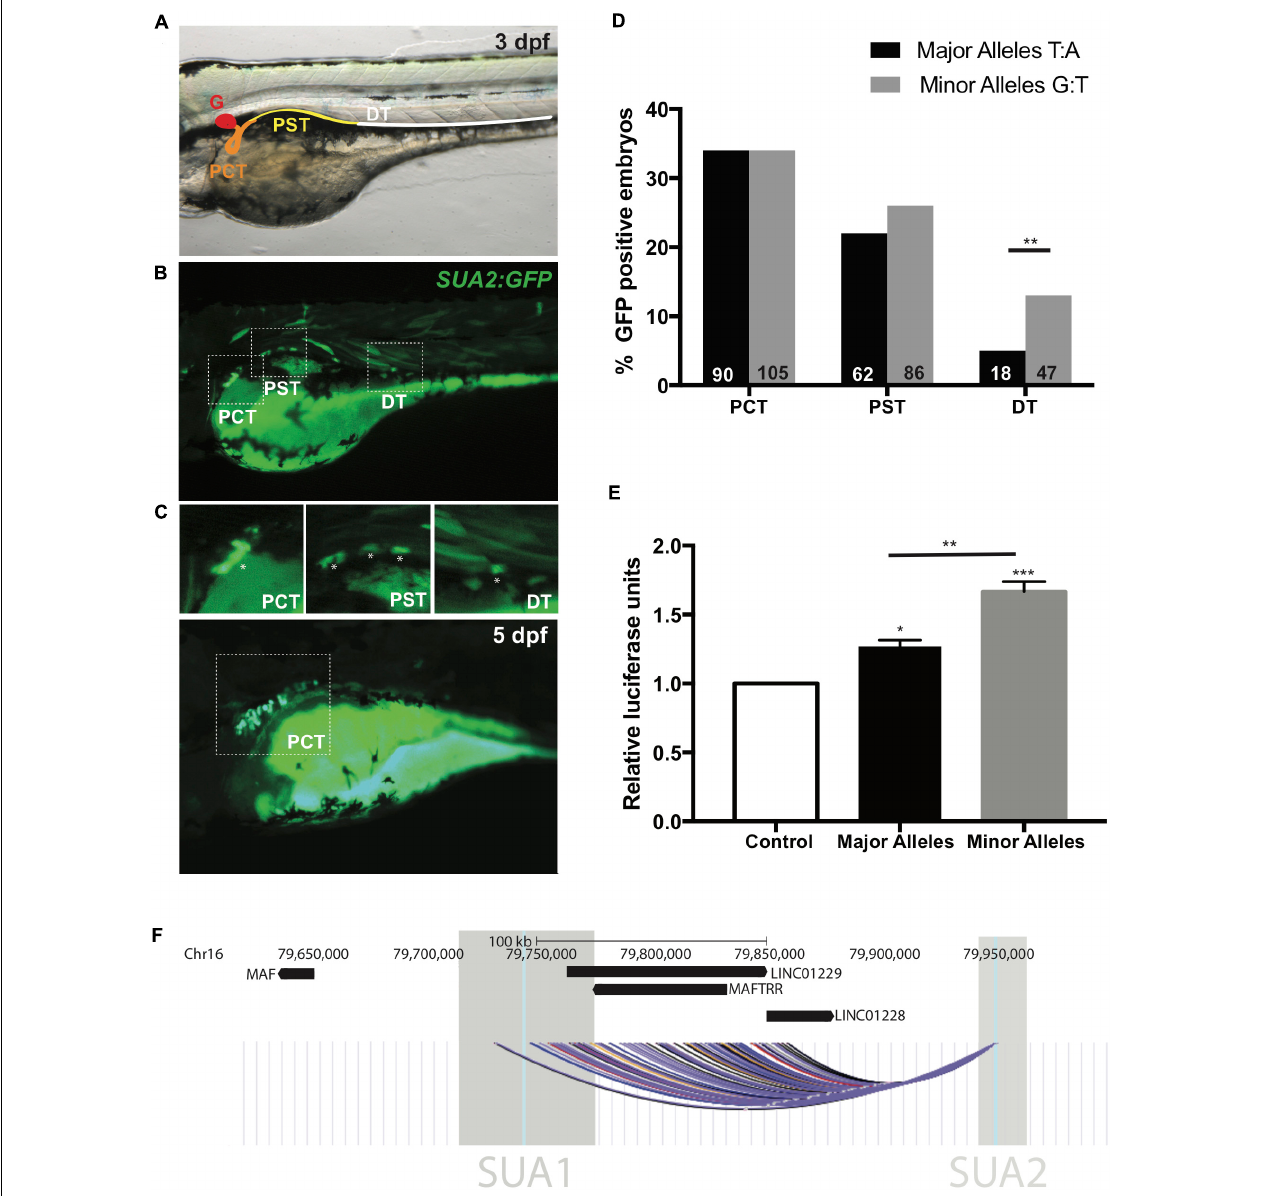
FIGURE 3 | SUA2 is a functional enhancer that physically connects to the lincRNA region. An enhancer construct containing the SNP region (e.g., major alleles) injected at the one-cell stage in developing zebrafish embryos drives transient GFP reporter expression in the proximal tubules of 24 hpf, 48 hpf, and 3 dpf embryos. (A) 48 hpf embryo with schematic depicting the zebrafish pronephros: glomerulus (G, red); proximal convoluted tubule (PCT, orange); proximal straight tubule (PST, yellow); distal tubule (DT, green). (B) Representative image from a 3 dpf embryo with mosaic GFP expression in the PCT, PST and DT. Insets of the PCT, PST and DT are below. Asterisks indicate GFP positive cells. (C) Representative image from a 5 dpf embryo with mosaic GFP expression found exclusively in the PCT. (D) Percentage of transgene positive embryos that present with GFP-positive cells in the PCT, PST, and DT in enhancer constructs containing the SNP region with either the major or minor alleles for SNPs rs4077450 and rs4077451 at 3 dpf. The total number of embryos that were transgene-positive for the major allele fragment was 349. The total number of embryos that were transgene-positive for the minor allele fragment was 413. Numbers in each group are represented at the bottom of each bar in the graph. (E) Luciferase reporter assay in HEK293 cells with an empty pGL4.23 vector (control), or a pGL4.23 vector containing the SNP region with either the major (urate-lowering) or minor (urate-raising) alleles of the SNP. Luciferase expression is plotted relative to the expression of Renilla and normalized to the expression from the empty vector. A one-way ANOVA test resulted in a significant difference between the means of the control and the SNP region containing both the minor and major allele and a significant difference between the means of the major and minor alleles. Asterisks indicate the set of values that were significantly different from the control; ∗ p < 0.05, ∗∗ p < 0.005 and ∗∗∗ p < 0.0005. (F) The intergenic region upstream of MAF that encompasses the lincRNAs MAFTRR, LINC01229 and LINC01228 . Also shown are the locations of SUA1 and SUA2. The region of interaction for the interaction fragment that encompasses the rs4077450_rs4077451 SNP region is indicated, data are from Rao et al. (2014) using K562 (black), NHEK (blue), IMR90 (yellow), HMEC (red), GM12878 (purple) and KBM7 (gray) cells. The interaction region is the combination of 45 interactions with the rs4077450_rs4077451 SNP region.